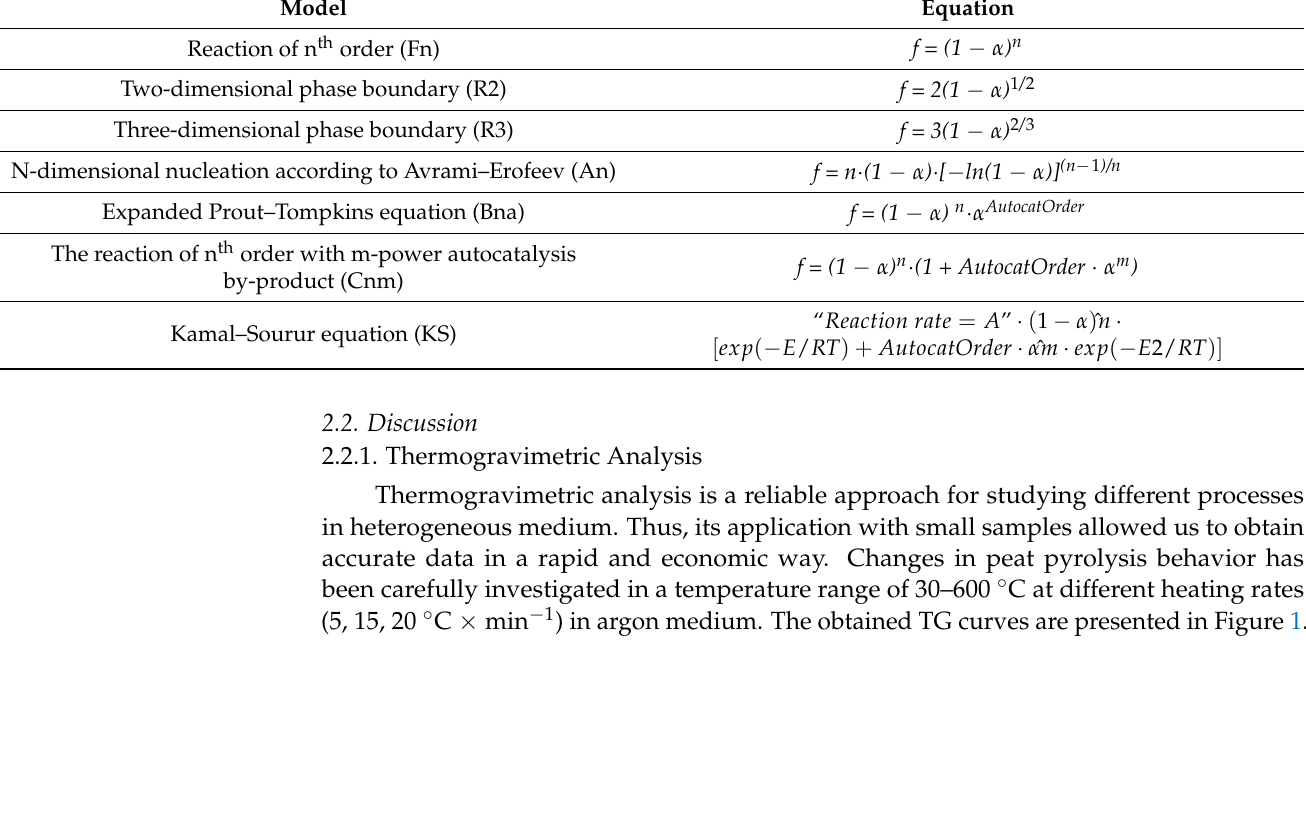
Table 2. Models’ methods for calculating kinetic parameters.